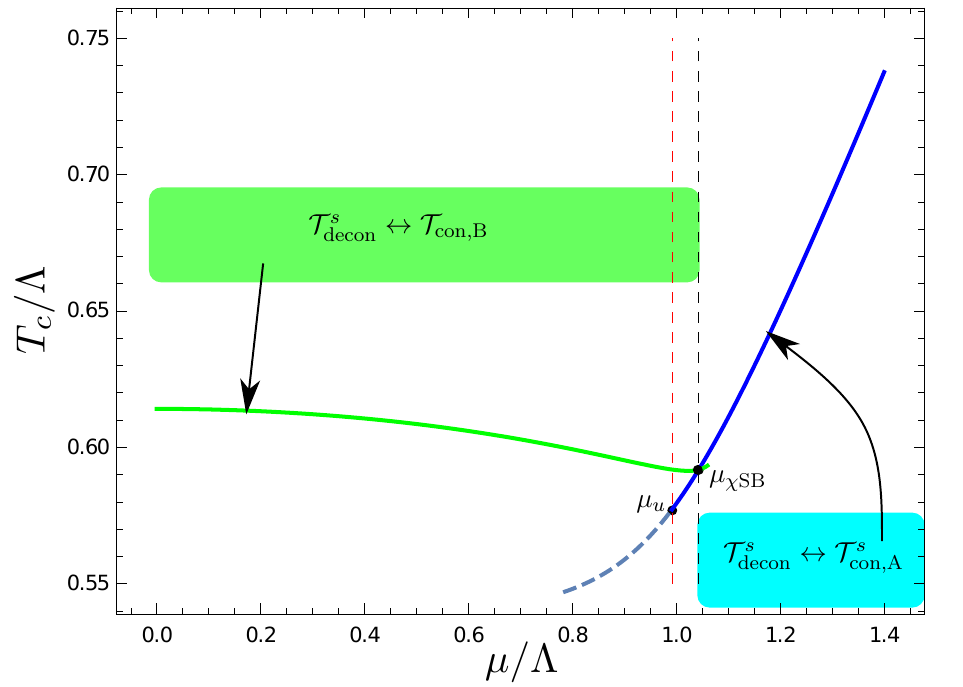
Figure 22 . The temperature T c of the confinement/deconfinement phase transitions between the different states in the cascading gauge theory; equivalently, the analog of the Hawking-Page phase transition between the Klebanov-Tseytlin black holes and the different Euclidean vacua of the conifold flux geometries. The deconfined states are the preferred ones for T > T c . s s green curve) and between and states (the blue curves). The decon con , A T T